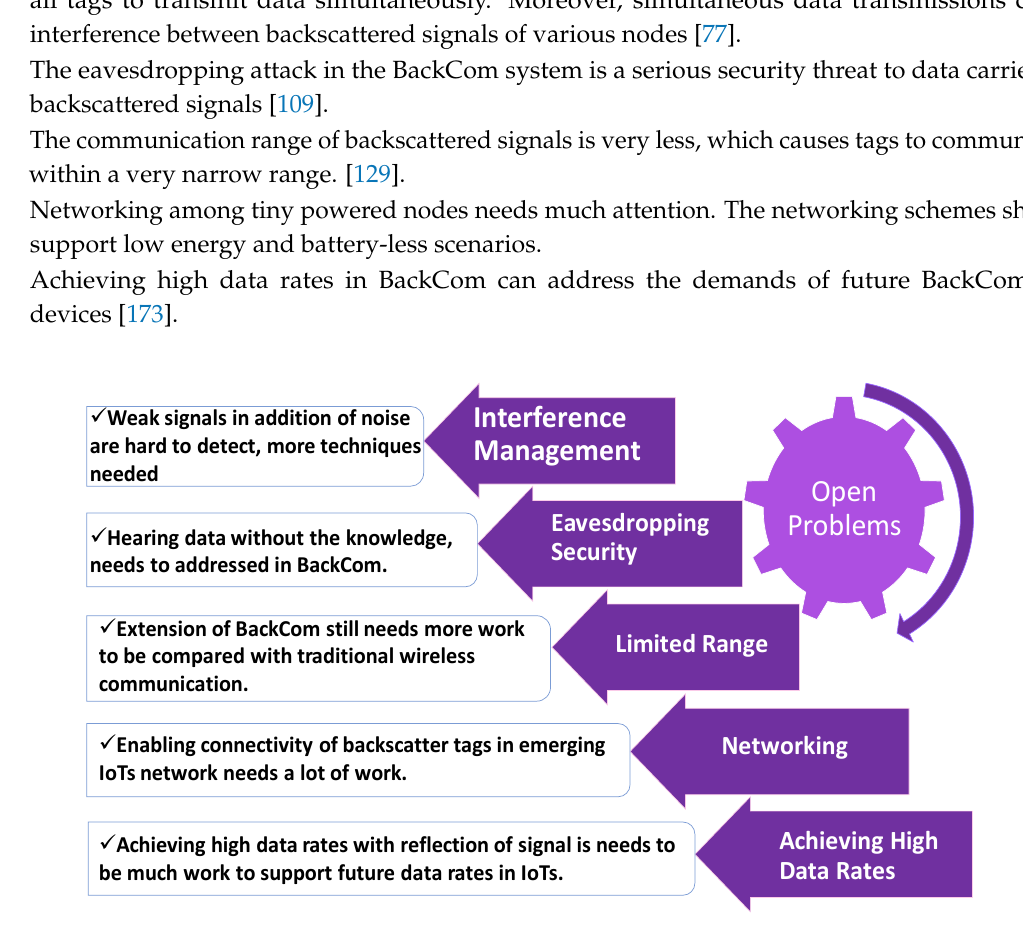
Figure 49. Open problems in